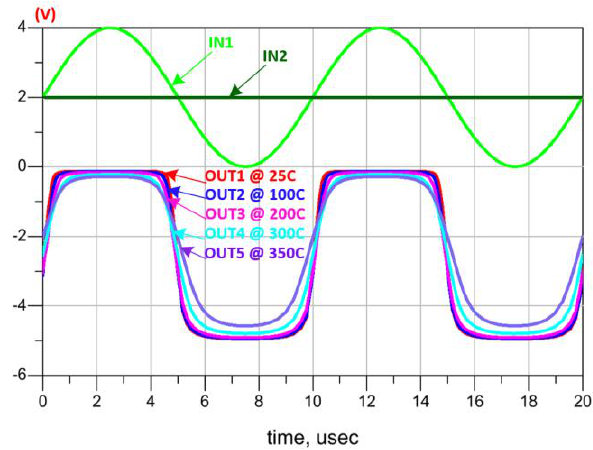
Figure 10. Comparator simulations at different temperatures.